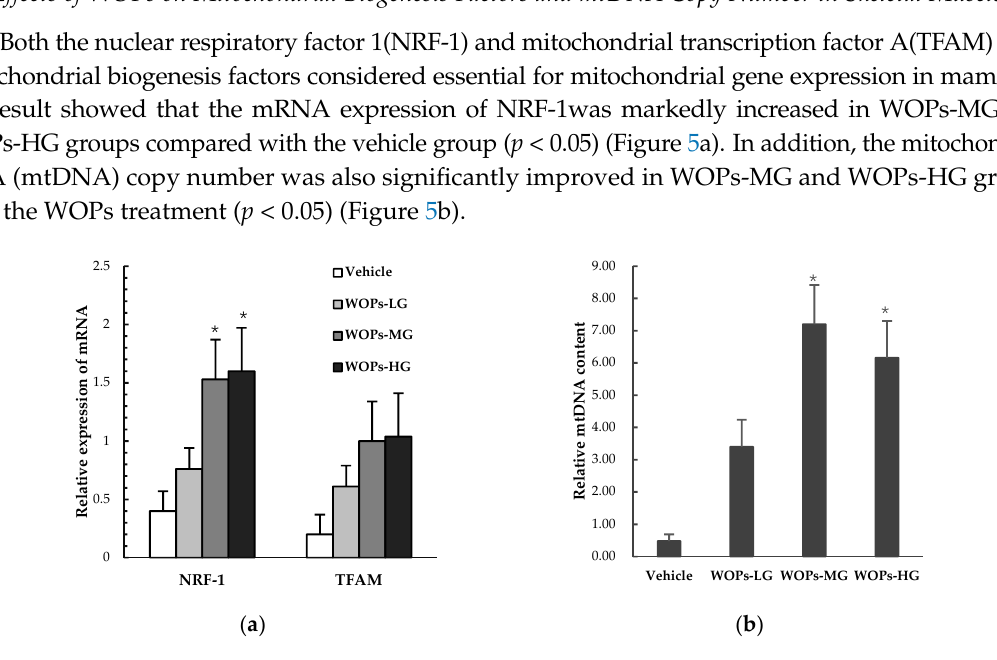
Figure 5. Effects of WOPs on the RNA expression of NRF-1, TFAM ( a ) and mtDNA copy number ( b ) in skeletal muscles of mice by real-time PCR analysis. β-actin mRNA levels were used as a control. Data are reprensated as means ± SD ( n = 10). * p < 0.05 versus vehicle group. NRF-1, Nuclear respiratory factor 1; TFAM, Mitochondrial transcription factor A; mtDNA, mitochondrial DNA.